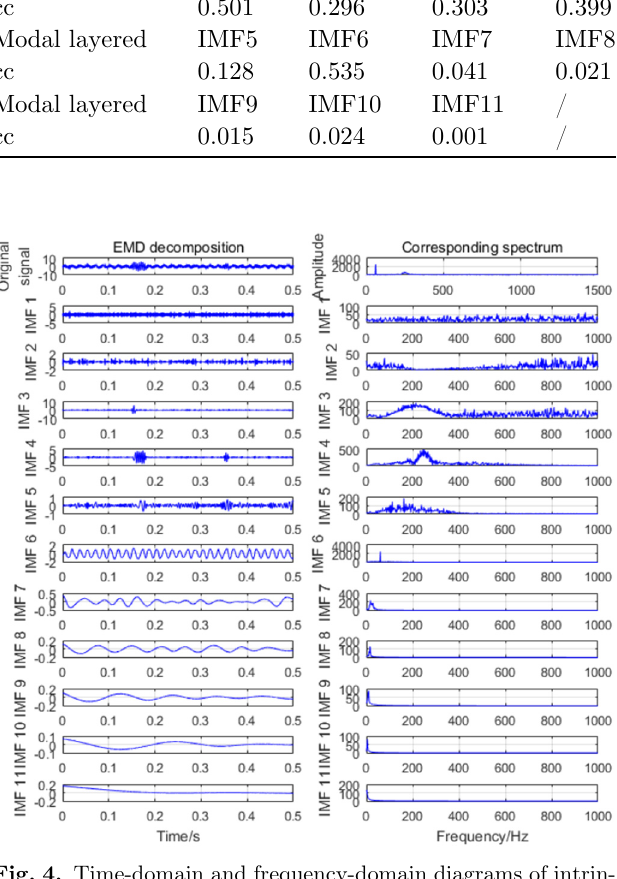
Fig. 4. Time-domain and frequency-domain diagrams of intrin- sic mode components after wavelet processing.